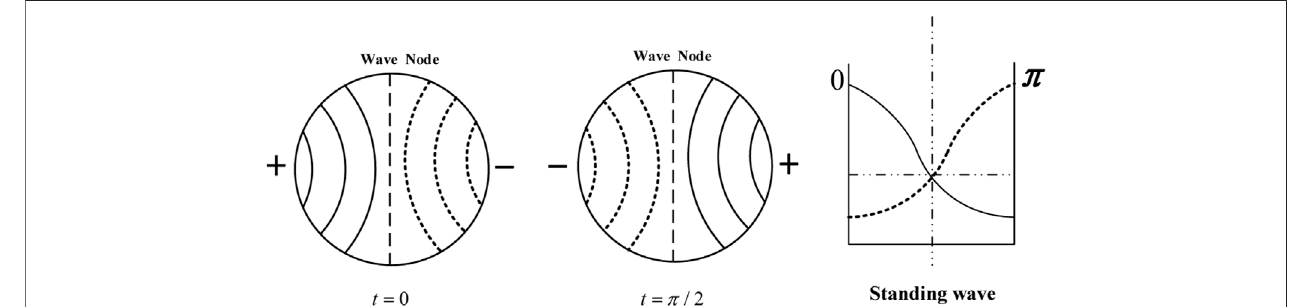
FIGURE 3 | Standing wave 1T vibration mode structure.